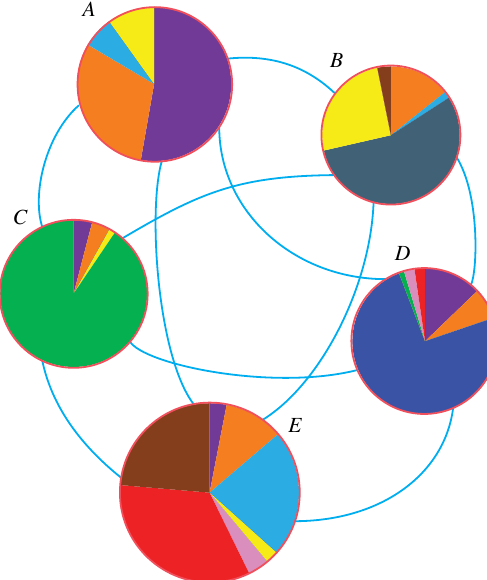
FIG. 7. Communities of the S&P 500 (log-returns of daily closing prices from 2001Q4 to 2011Q3) generated using our correlation-based modularity Q 3 ð ~ σ Þ with the Louvain algorithm (see the Appendix). Individual communities are labeled A through E , and the pie chart represents the relative composition of each community based on the industry sectors of the constituent stocks (color legend in Table I). The blue intercom- munity link weights are negative, indicating that the communities are all residually anticorrelated. The red circles around each community indicate that the total intracommunity correlations are all